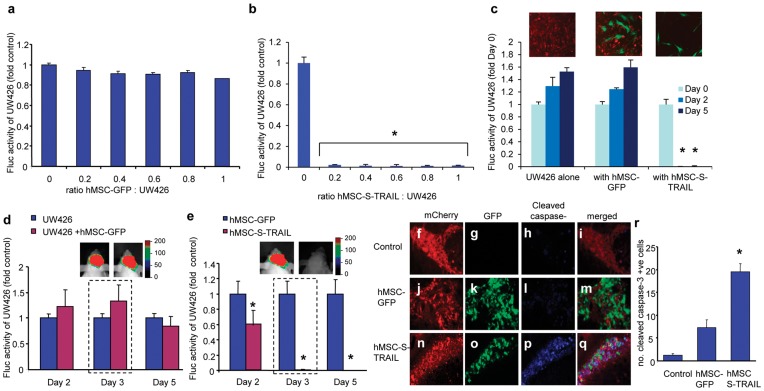
UW426 MB cells are sensitive to stem cell-delivered TRAIL.(a) Plot showing the viability of UW426-Fluc-mCherry MB cells co-cultured with hMSC-GFP cells with different ratios of hMSC to MB cells. (b) Plot showing the viability of UW426-Fluc-mCherry MB cells co-cultured with hMSC-S-TRAIL cells with different ratios of hMSC to MB cells. (c) Plot showing the viability of UW426-Fluc-mCherry cells on 0, 2, 5 days of co-culture with hMSC-GFP or hMSC-S-TRAIL cells. Representative pictures showing UW426 (red) co-cultured with hMSC (green) obtained on day 5. (d) Plot showing Fluc bioluminescence activity of intra-parenchymally implanted mice with UW426-Fluc-mCherry cells with or without hMSC-GFP on days 2, 3, and 5 post-implantation. Representative images are shown from one mouse per group on day 3. (e) Fluc bioluminescence activities of intra-parenchymally implanted UW426-Fluc-mCherry cells with hMSC-GFP or with hMSC-S-TRAIL at 2, 3 and 5 days post-implantation. Representative images are shown from one mouse per group on day 3. (f–q) Photomicrographs and immunohistochemistry of brain sections on day 2 from mice bearing UW426-Fluc-mCherry tumors alone or with hMSC expressing either TRAIL and GFP or GFP. (r) Plot showing the number of cleaved caspase-3-positive UW426 cells in tumors without hMSC or with hMSC-GFP or hMSC-S-TRAIL (Original magnification: c, ×10; f–q, ×20.). * denotes p<0.05 in the comparison of each treatment to controls, student’s t-test.